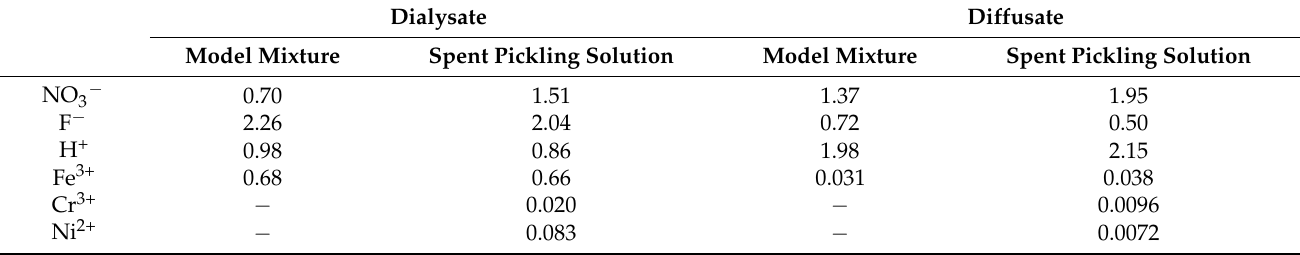
Table 2. The composition of the dialysate and the diffusate (mol L − 1 ) for 150 mL h − 1